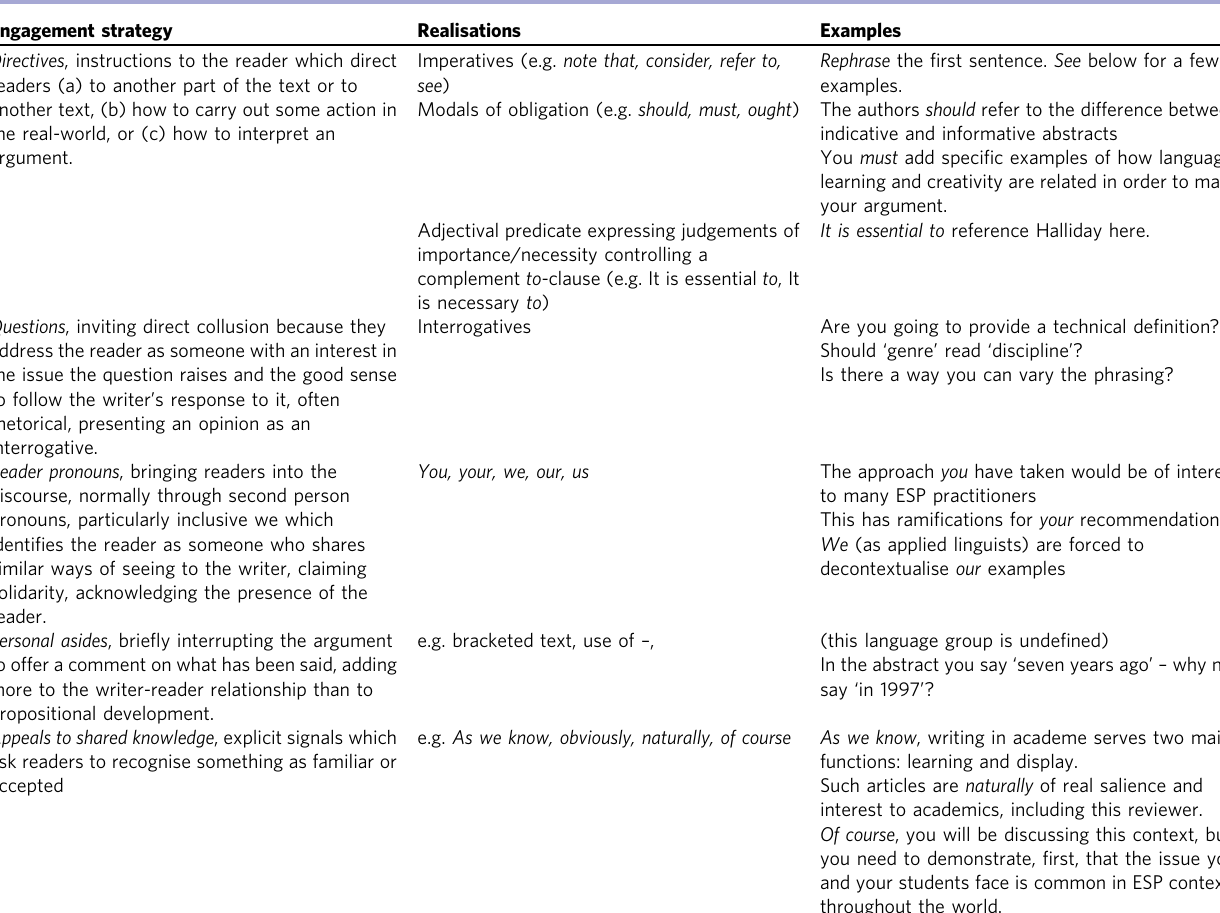
Table 1 Engagement strategies, realisations, and examples (Paltridge, 2020, pp. 10 – 11). Engagement strategy